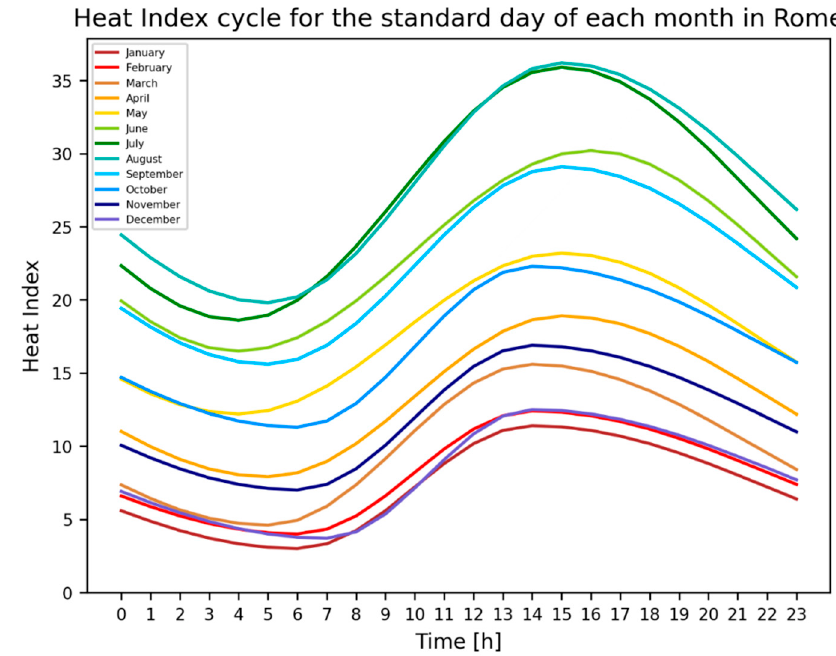
Figure 5. Hourly distribution of Heat Index for the monthly standard days in Rome.